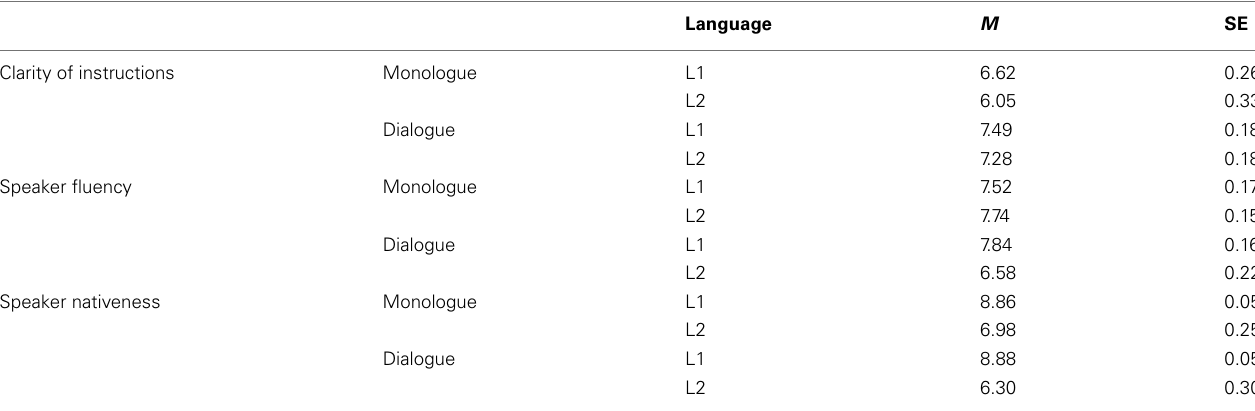
Table 3 | Mean ratings and SEs of the mean/or clarity of instructions, speaker fluency, and nativeness for monologues and dialogues in L1 and in L2.